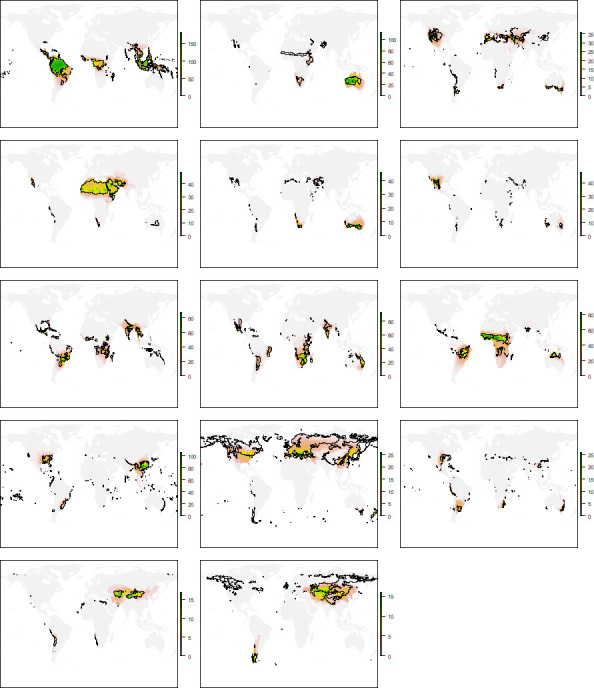
Distribution of the climatic conditions (black line) and the species (colored richness values) belonging to the same niche domains of reptiles.